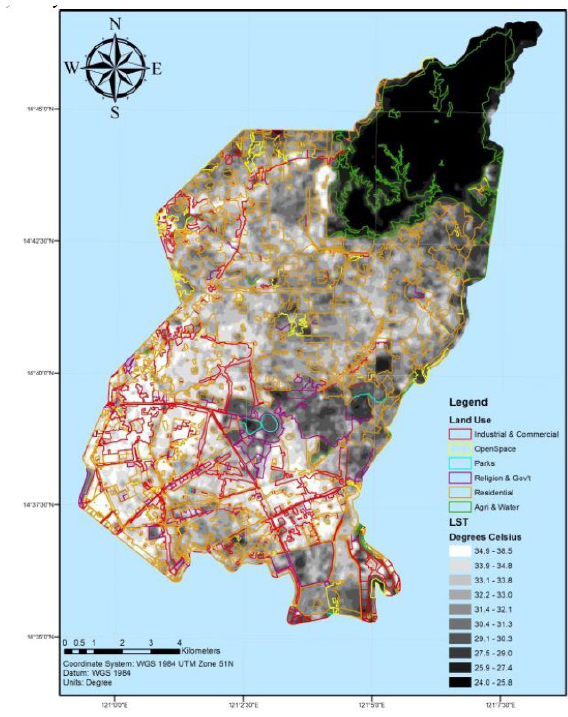
Figure 1. Land use and land surface temperature of Quezon City (Source of map: Alcantara et al., 2019)